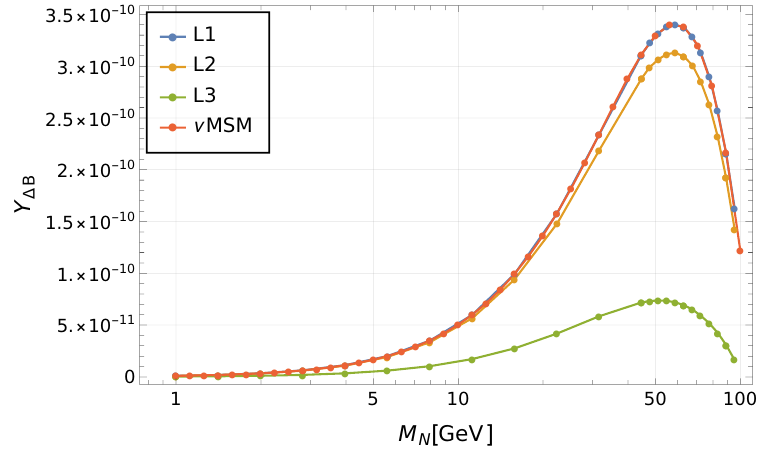
Figure 5. Total baryon asymmetry production as a function of the sterile neutrino mass M 0 three lines L 1 , L 2 , L 3 are chosen parallel to the blue area. The remaining parameters are fixed to λ SH = 10 − 3 , λ S = 10 − 2 and α = 10 − 8 . See text for more